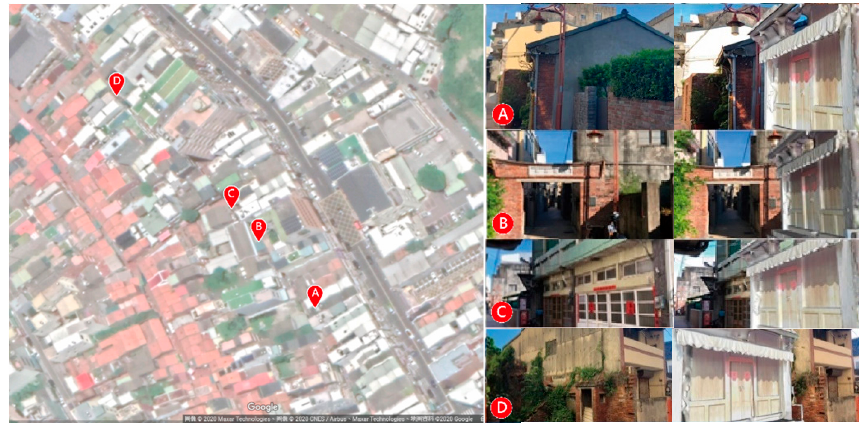
Figure 13. AR screenshots of relocating façades on alternative sites in Houche Lane, Lukang.